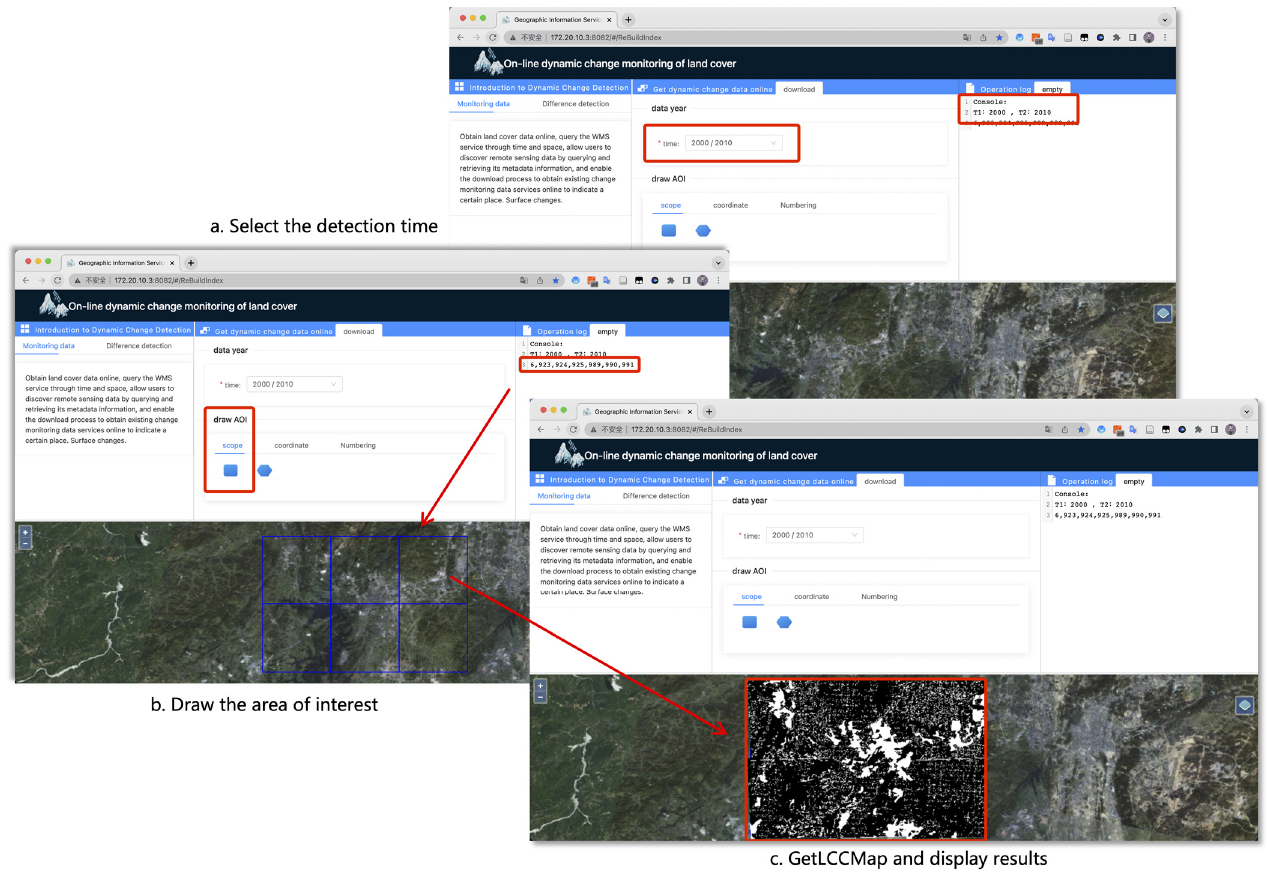
Figure 11. Application of obtaining the LCC data.